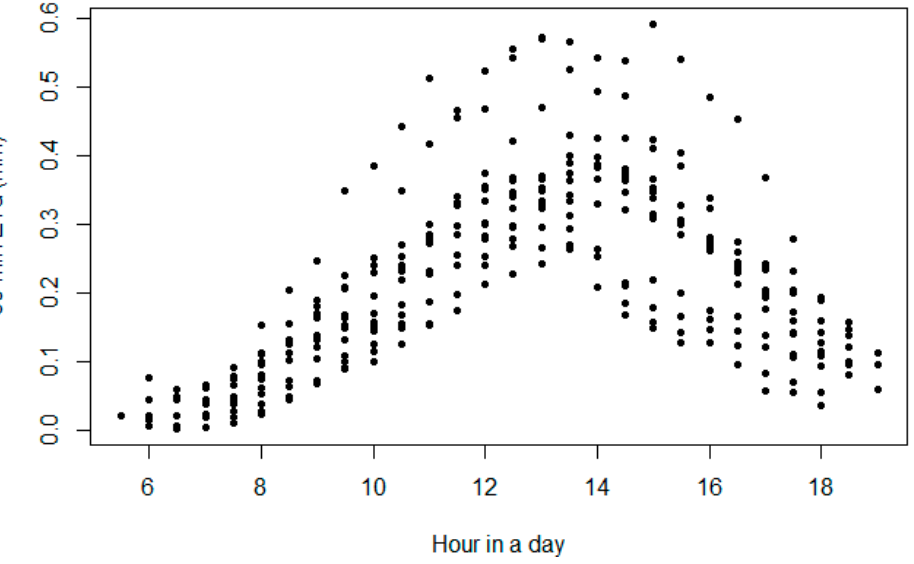
Figure 3. The diurnal patterns of 30 ‐ min daytime ET a across all days in the season with complete data (FUL days). The values of 30 ‐ min ET a generally peak around 1:30 p.m. and follow the shape of an incomplete half ‐ sine curve.